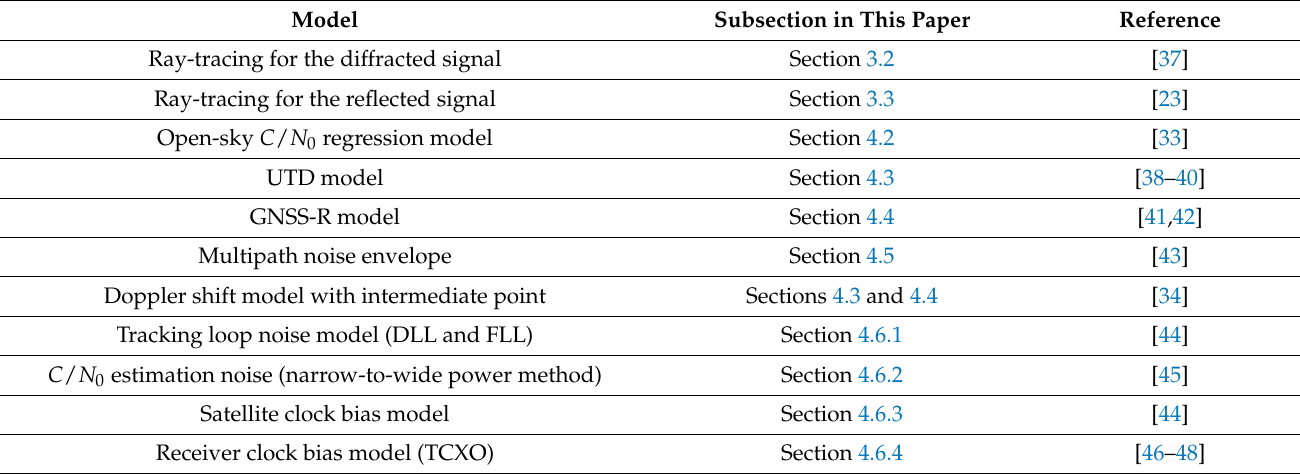
Figure 1. The flowchart of the proposed global navigation satellite system (GNSS) realistic urban multiagent simulator, GNSS RUMS. Table 1. The employed models and the corresponding references in the proposed simulator.